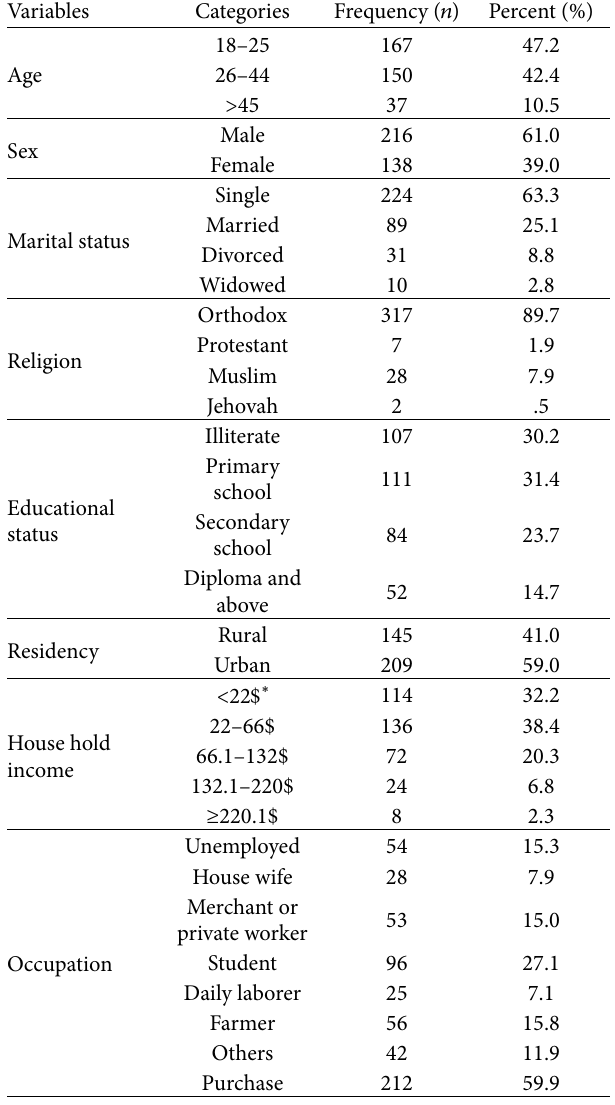
Table 1: Socio-demographic characteristics of study participants, UoGRH, 2017.